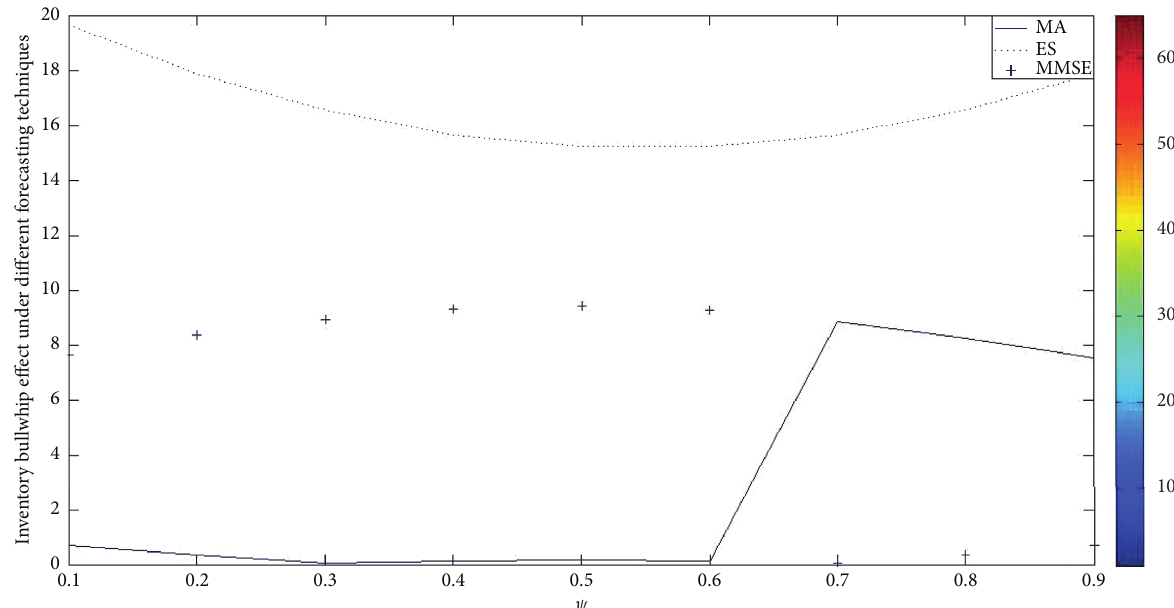
and ρ on the inventory bullwhip effect using different forecasting techniques. 1 2